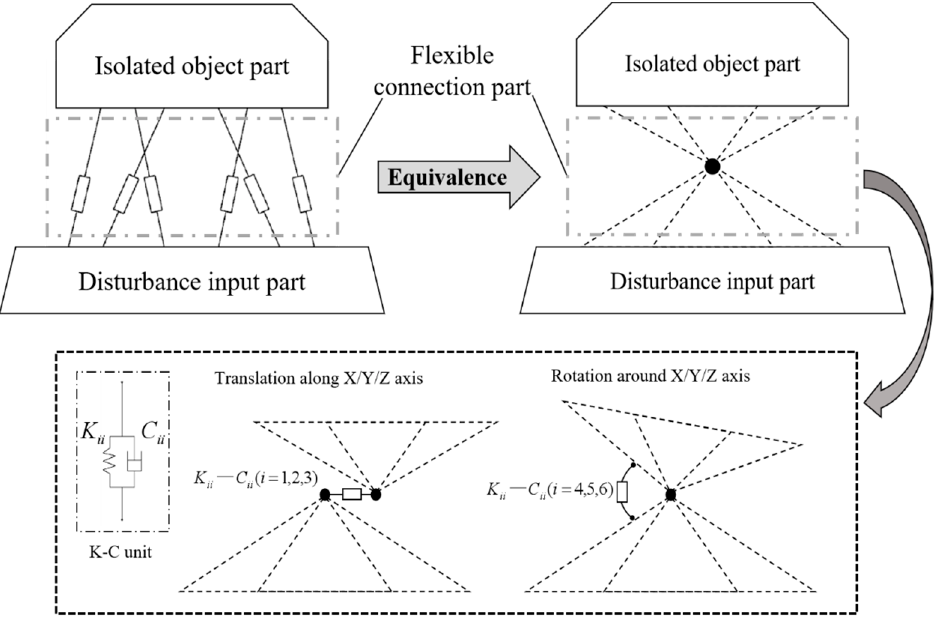
Figure 4. Schematic of equivalent conversion SVIS.